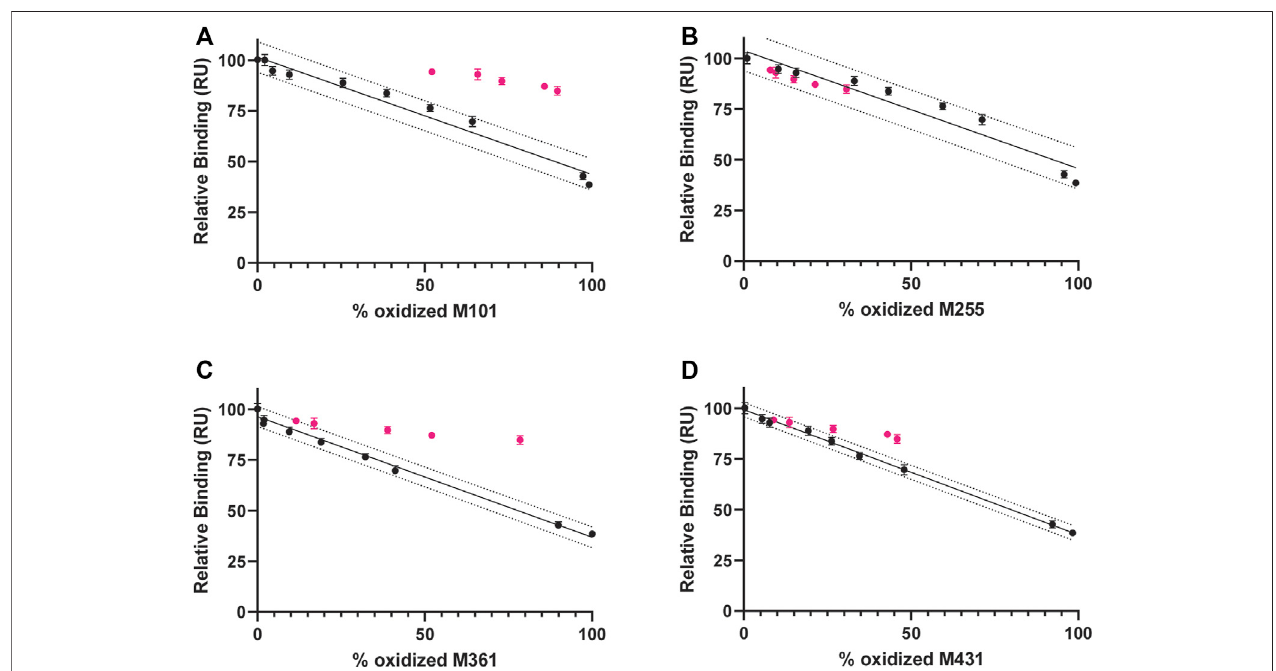
FIGURE 7 | Correlation between protein A binding and Met ox ( 0.3% Nox samples in black and CPA samples in pink) and linear regression analysis of Nox samples (solid black line) with 90% prediction bands (dotted black line) (A) M101 (B) M255 (C) M361 (D)